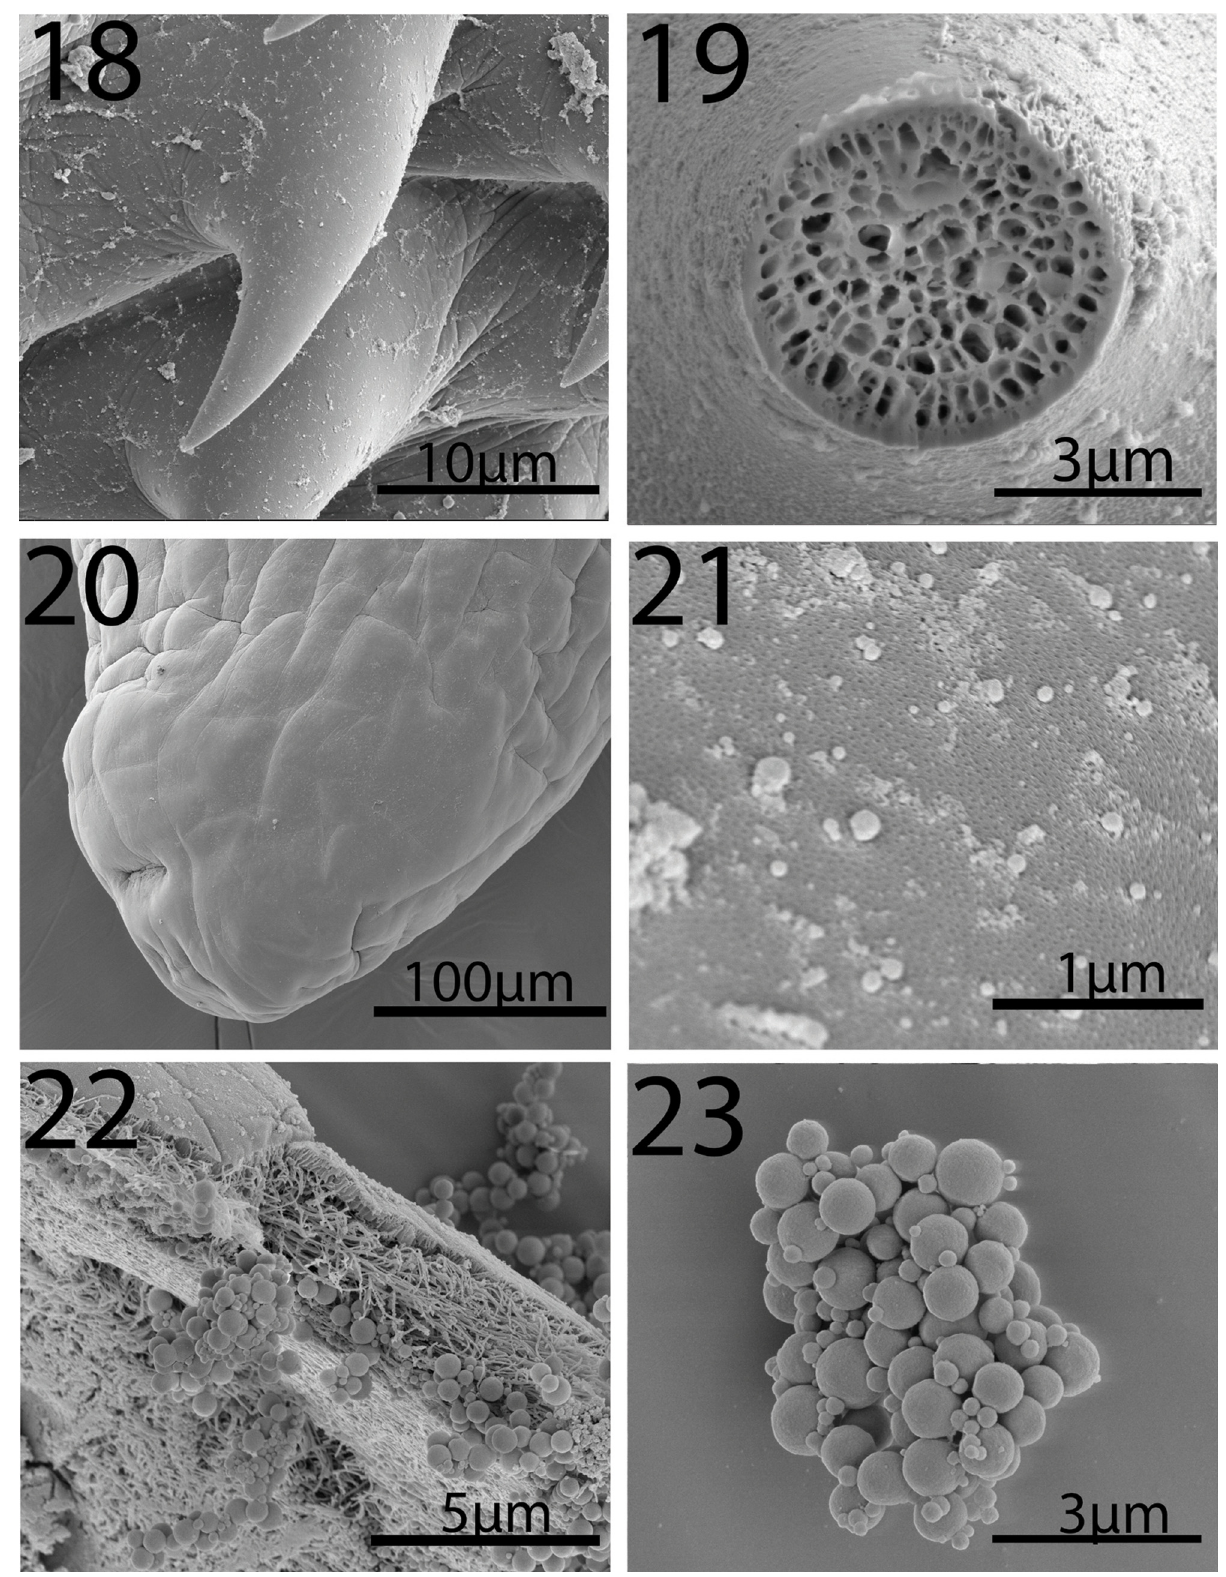
Figures 18-23. SEM of cystacanths of Neoandracantha peruensis from ghost crabs, Ocypode gaudichaudii , from the Paci fi c Ocean off Peru. 18. A spine from the posterior fi eld of the foretrunk spines. 19. A gallium cut cross-section of a spine showing its spongy structure. 20. The posterior end of a female hindtrunk showing the subterminal position of the gonopore (lower left). 21. Micropores at the foretrunk of a female specimen. 22. Eggs in the body cavity of a female at the foretrunk-midtrunk junction. 23. A small cluster of eggs showing their different developmental